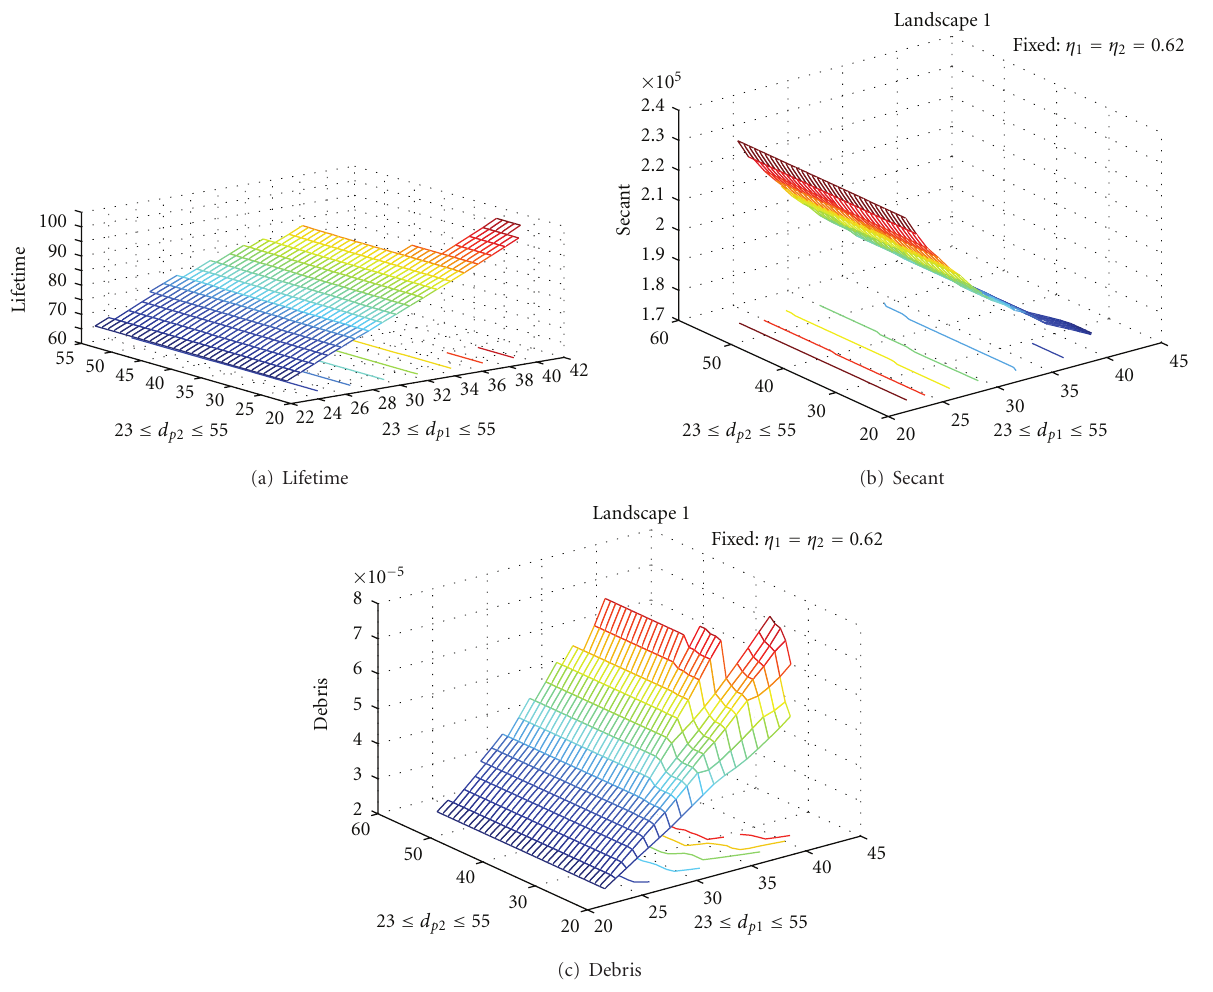
Figure 3: Landscapes with η 1 = η 2 = 0 . 62 while d p 1 , d p 2